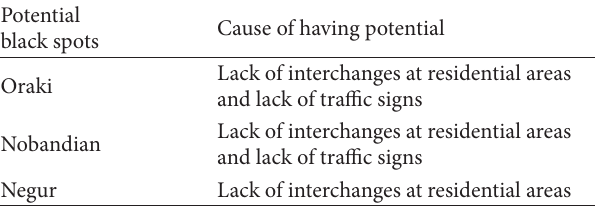
Table 7: Section 7: